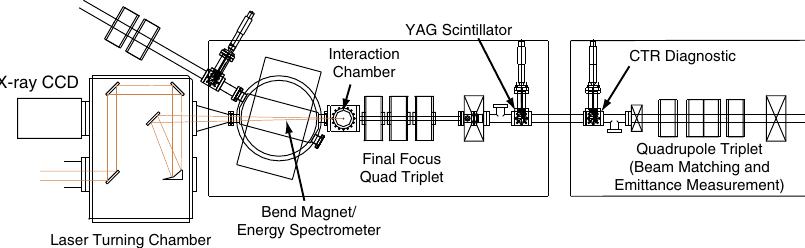
FIG. 28. (Color) Schematic layout of the PLEIADES ICS x-ray source experiment.